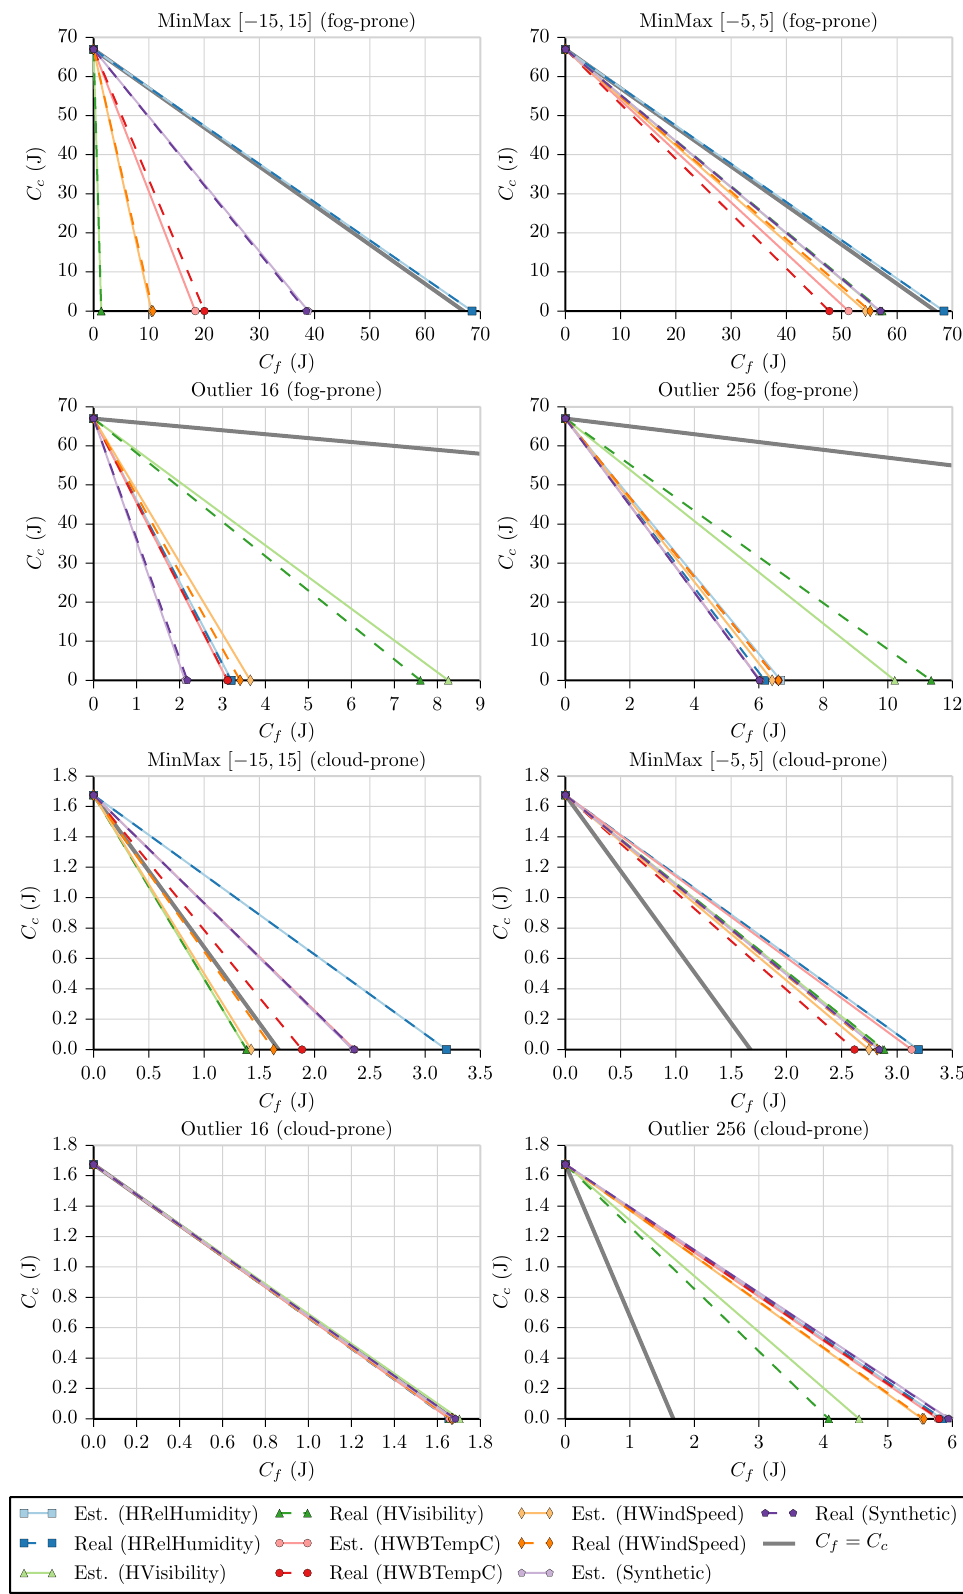
Figure 11. Graphs of the linear equations for each dataset and benchmark using energy consumption as the cost: